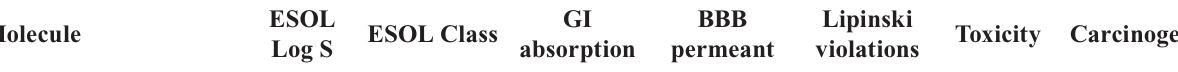
TABLE II - Results of Drug likeness from both plants